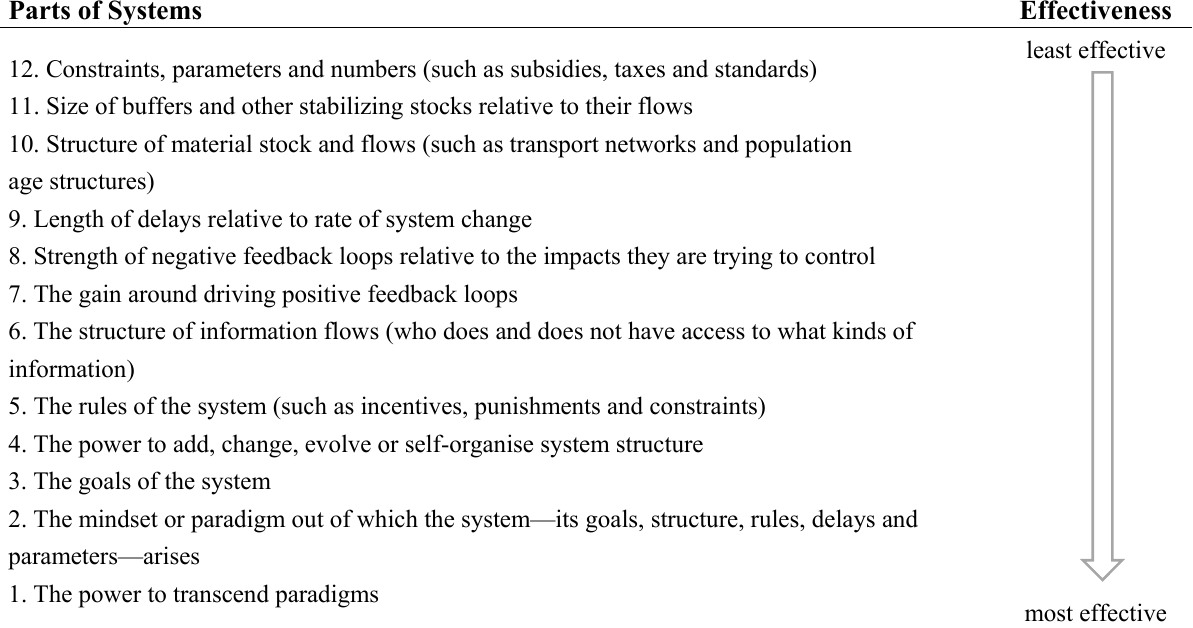
Table 1. How to change systems